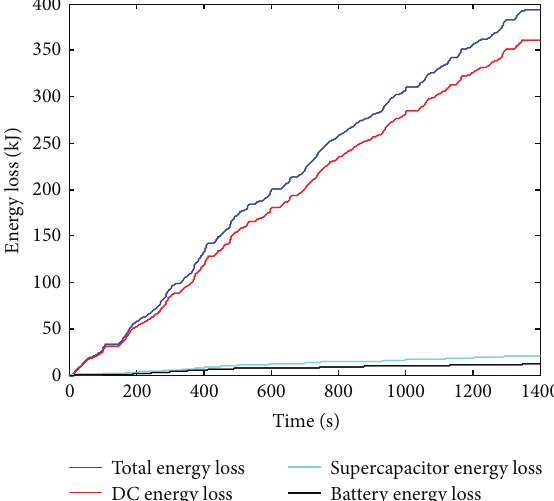
Figure 31: Efficiency map of the DC/DC converter.